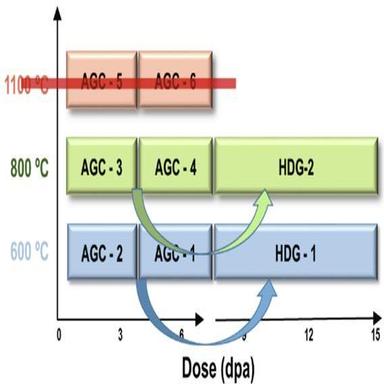
AGC graphite irradiation experiment illustrating recent changes to a higher dose level and elimination of high temperature irradiations.